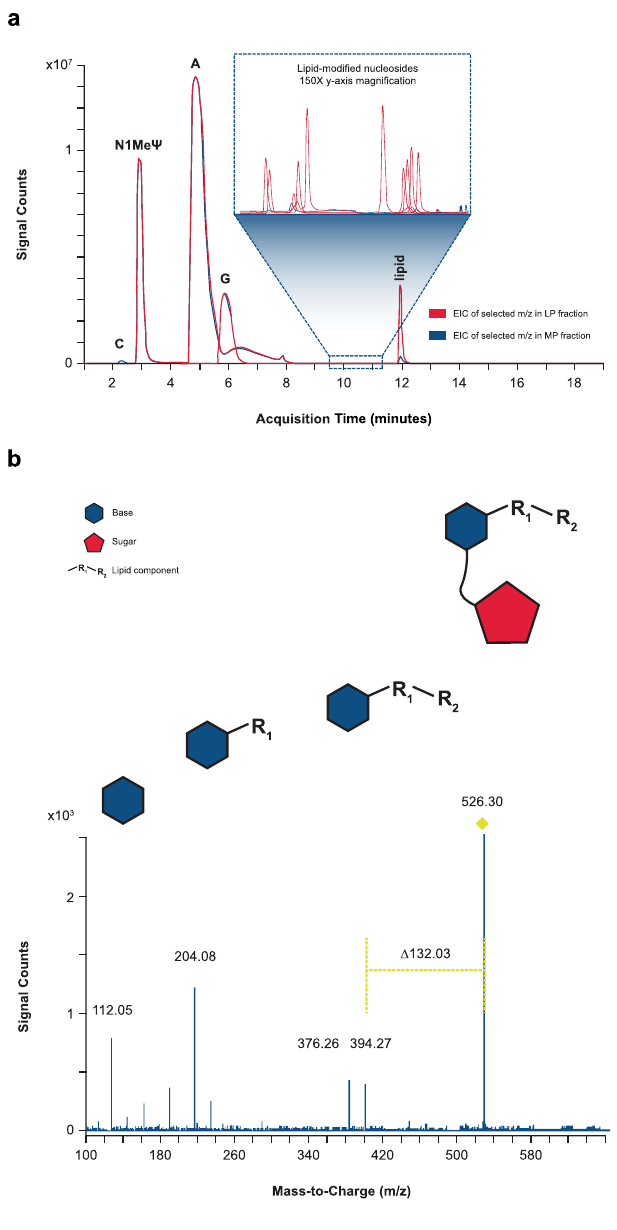
Fig. 3 Identi fi cation of single modi fi ed nucleosides by LC/MS/MS. a Isolated mRNA main peak (MP) and late eluting-peak (LP) were enzymatically digested to single nucleosides and analyzed by liquid chromatography with tandem mass spectrometry (LC/MS/MS). Extracted ion chromatograms (EICs) of selected mass-to-charge ratios (m/z) corresponding to various unmodi fi ed nucleosides, lipid-modi fi ed nucleosides, and carry-over lipid in LP (red) and MP mRNA (blue) fractions are overlaid. The selected m/z for EICs include unmodi fi ed nucleosides (cytidine [C; 2.3 min], N1-methylpseudouridine [N1-MelJ.I; 3 min], adenosine [A; 5 min], guanosine [G; 6 min]), lipid (11.9 min), and